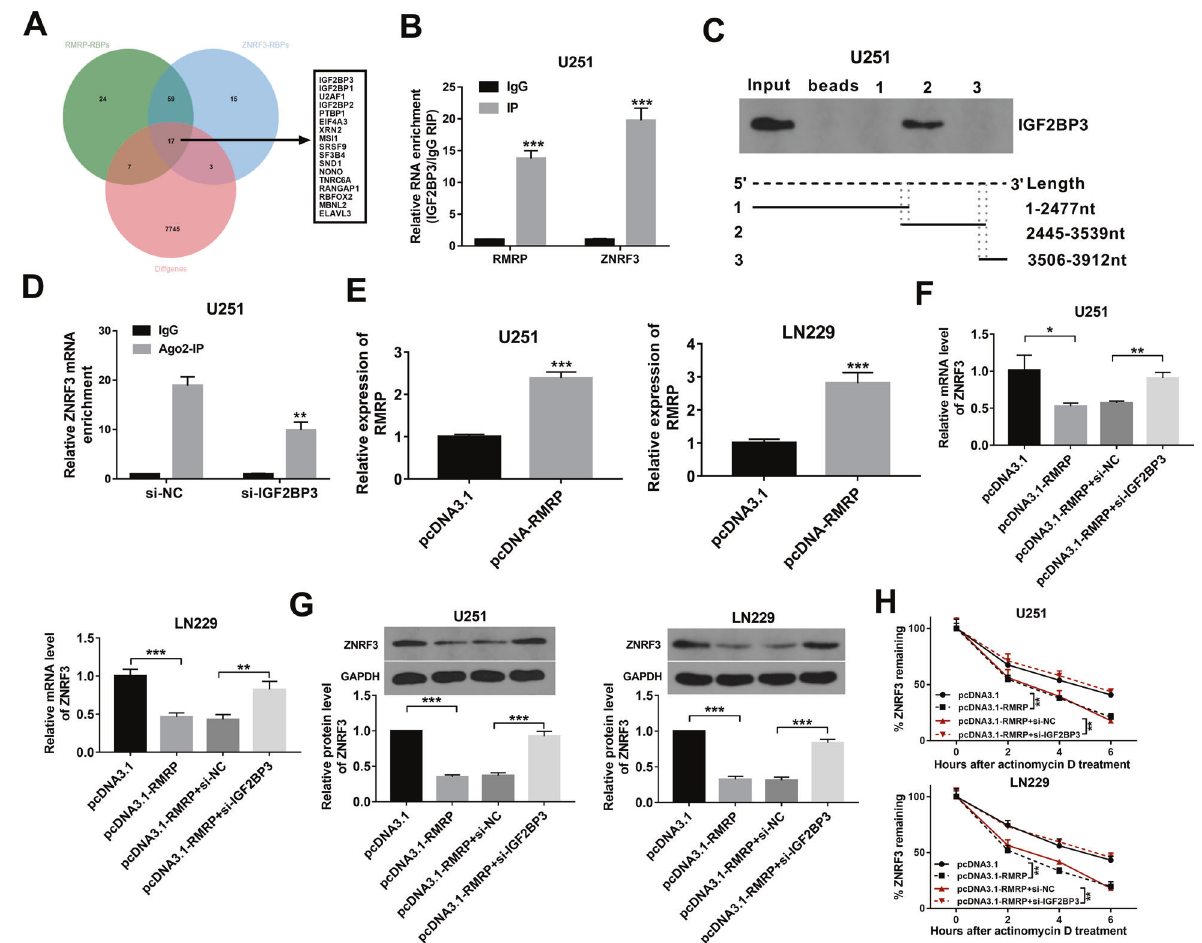
Fig. 6 RMRP regulated ZNRF3 expression and ZNRF3 mRNA stability through RBP IGF2BP3. A Venn analysis for RMRP-RBPs, ZNRF3-RBPs, and differentially expressed genes in glioma versus normal tissues. RMRP-RBPs (green): RBPs with the possibility to bind with RMRP (predicted by the POSTAR database). ZNRF3-RBPs (blue): RBPs with the possibility to bind with ZNRF3 mRNA (predicted by the POSTAR database). Diffgenes (red): Differentially expressed genes in glioma versus normal brain tissues (data were downloaded from the TCGA/GTEx databases). B RIP assay was performed using IgG or IGF2BP3 antibody in U251 cells. Next, RMRP and ZNRF3 mRNA levels enriched by IgG or IGF2BP3 antibodies were measured by RT-qPCR assay ( n = 3). C RNA pull-down assay was performed using biotin-labeled ZNRF3 mRNA 3 ’ UTR fragment 1, fragment 2, and fragment 3 in U251 cells, followed by the detection of IGF2BP3 protein level via western blot assay. D U251 cells were transfected with si-NC or si-IGF2BP3. At 48 h after transfection, a RIP assay was performed using IgG or Ago2 antibody. E U251 and LN229 cells were transfected with pcDNA3.1 or pcDNA3.1-RMRP. Forty-eight hours later, the RMRP level was measured by RT-qPCR assay ( n = 3). F , G U251 and LN229 cells were transfected with pcDNA3.1, pcDNA3.1-RMRP, pcDNA3.1-RMRP + si-NC, or pcDNA3.1-RMRP + si-IGF2BP3. F , G ZNRF3 mRNA and protein levels were determined by RT-qPCR and western blot assays ( n = 3). H ZNRF3 mRNA stability was tested by Actinomycin D and RT-qPCR assays ( n = 3). ** P < 0.01. *** P <